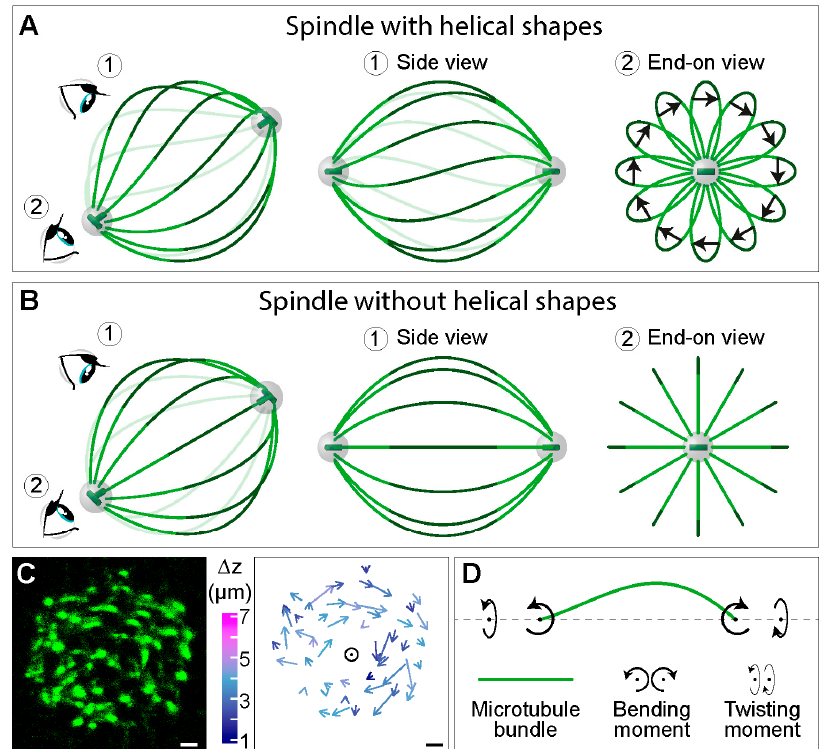
Figure 5. Twisting moment in the spindle leads to its chirality. Simplified scheme of a spindle ( A ) with and ( B ) without helical shapes of microtubule bundles. In each panel, a view of the spindle from an arbitrary angle is shown at the left, together with eye signs marking the view angle for the side view (1) and the end-on view (2), which are shown in the middle and on the right, respectively. Green lines depict interpolar microtubule bundles, the central part of which is marked in a darker shade. The arrows in (A) connect the end points of the central part of each bundle, following the bundle in the direction towards the observer. Grey spheres represent centrosomes with centrioles (green) inside. ( C ) Left, cross section of a spindle in a HeLa cell expressing PRC1-GFP (green), which marks the central part of interpolar bundles, i.e., bridging fibers [30]. Right, arrows connecting starting and ending points of PRC1-GFP bundles traced in the direction towards the observer. Longer arrows roughly correspond to larger twist around the spindle axis (circle) and colors show z -distance between starting and ending points (see color bar to the left). Scale bars, 1 µ m. The images are reproduced with permission from [10]. ( D ) Scheme of an interpolar microtubule bundle (green) illustrating a physical explanation of the bundle shape, where twisting and bending moments (curved arrows) acting on the bundle generate the observed chiral